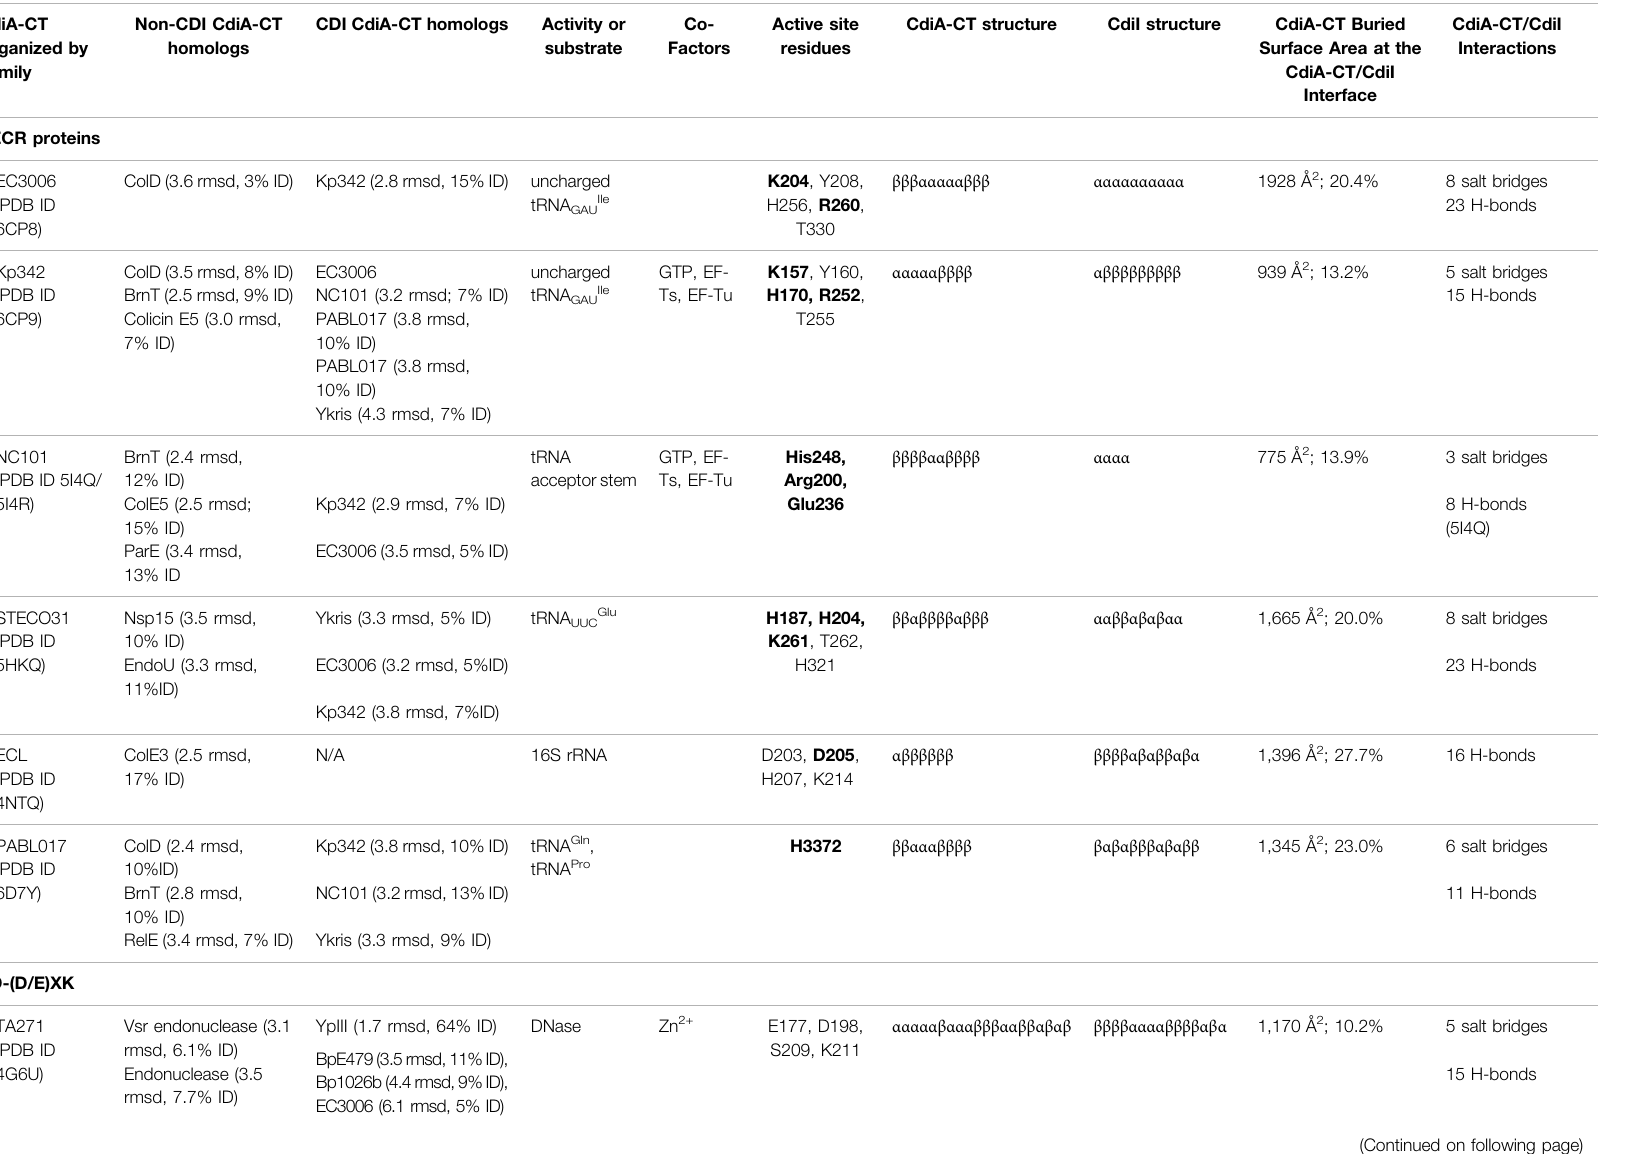
TABLE 1 | Summary of different CDI toxin activities, active sites, and homology to other known structures. CdiA-CT Organized